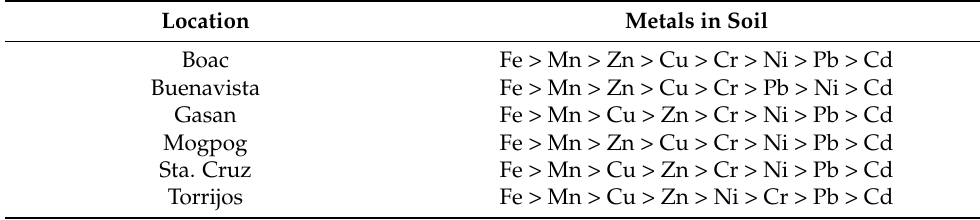
Table 3. Trend of metal concentrations in the soil across the province.